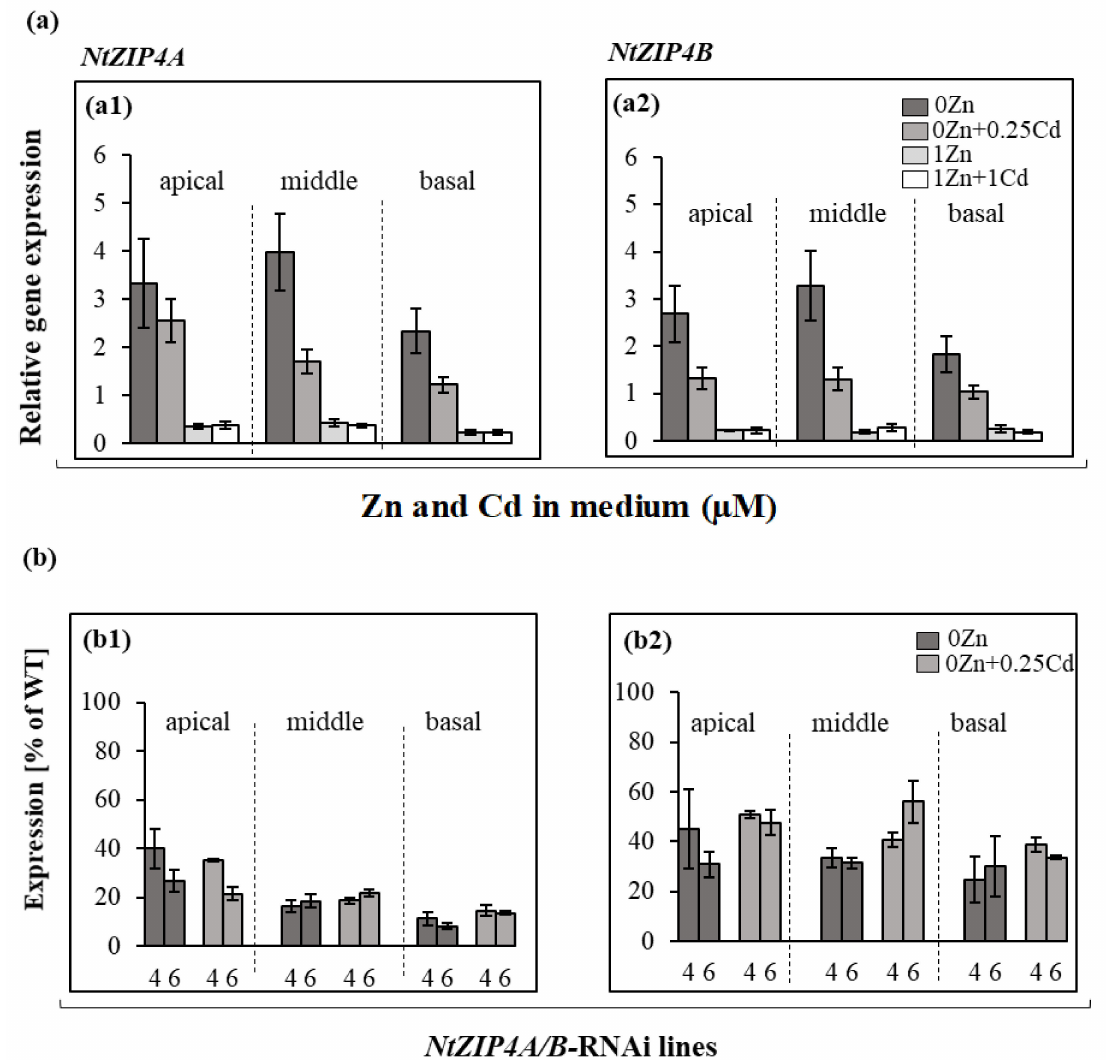
Figure 6. NtZIP4A and NtZIP4B transcript levels in the root parts of wild-type and NtZIP4A / B -RNAi plants grown at various Zn and Cd concentrations. 3.5-week-old plants of wild-type (WT) and NtZIP4A / B -RNAi lines (number 4 and number 6) grown in the quarter-strength Knop’s medium were exposed for 17 days to the control medium supplemented with pairwise combinations of Zn (0; 1 µ M) and Cd (0; 0.25; 1 µ M) concentrations. Transcript levels were monitored by RT-qPCR in the apical, middle, and basal root parts ( a ). Expression in the wild-type plants of NtZIP4A ( a1 ) and NtZIP4B ( a2 ). Expression of NtZIP4A ( b1 ) and NtZIP4B ( b2 ) in the NtZIP4A / B -RNAi plants were shown as a percentage of expression of the wild-type in the same part of the root grown at the same medium composition ( b ). The transcript levels of NtZIP4A and NtZIP4B were normalized to PP2A level. Values correspond to means ± SD ( n = 3); those with a ratio greater than 2 are considered significantly different (marked by an asterisk)